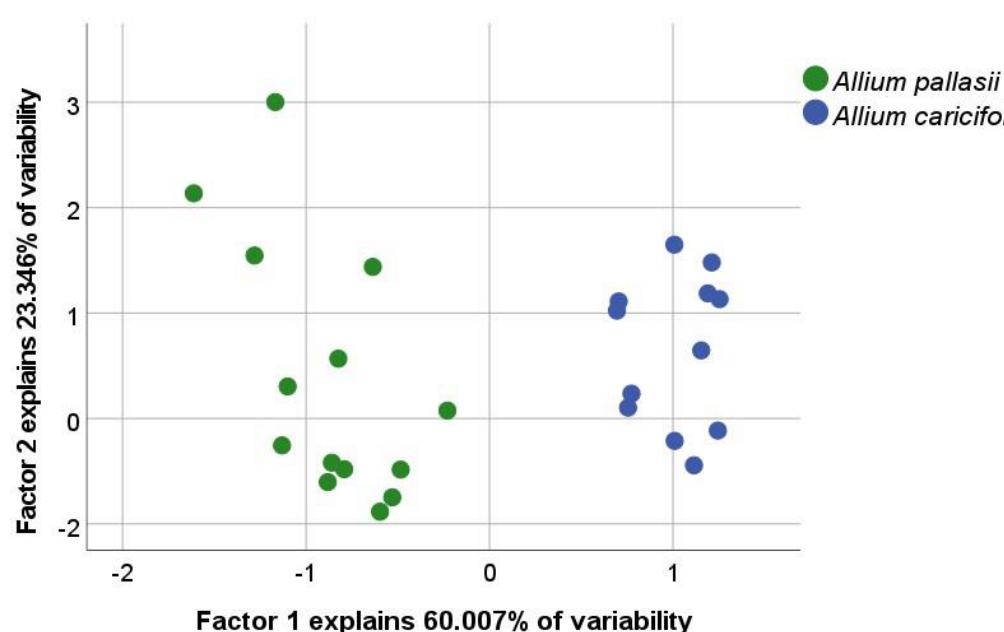
Figure 3. PCA analysis of morphological characters, shown in Table 1.